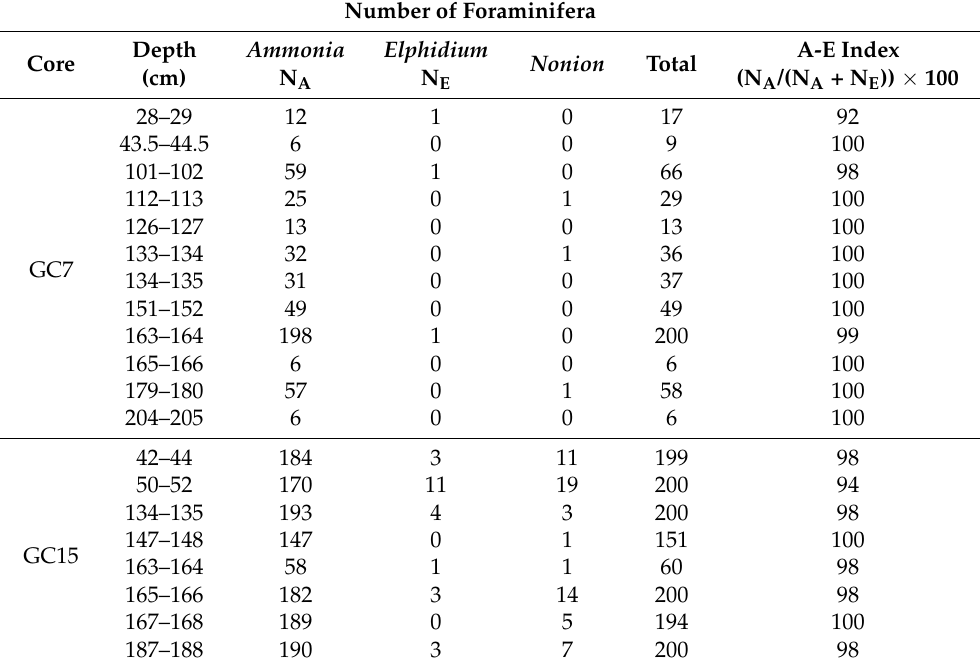
Table A4. Number of Ammonia , Elphidium and Nonion foraminifera counted in GC7 and GC15 samples with the calculated values of the A-E index (for the fraction > 150 µ m). Total foraminifera includes non-identified individuals (minor genus or badly preserved).